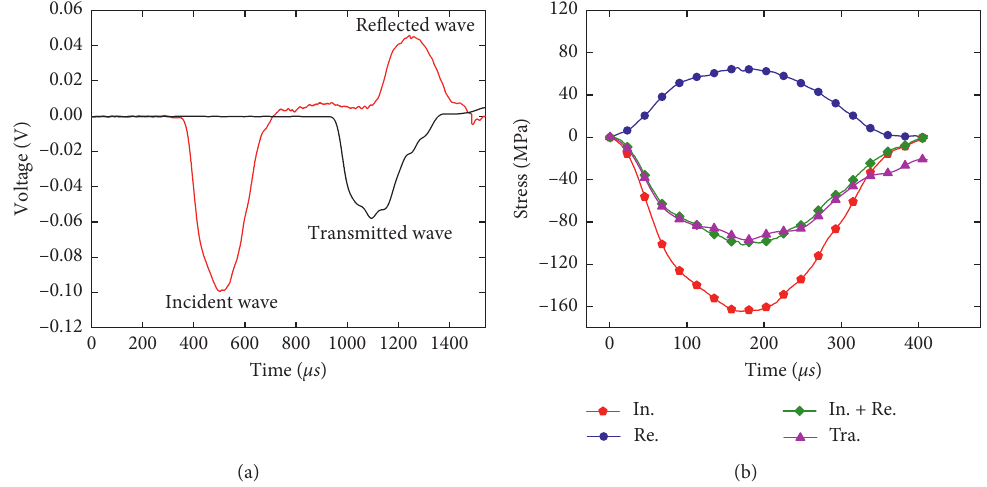
Figure 2: (a) Typical wave form of electrical signal and (b) dynamic stress equilibrium of jointed specimen.